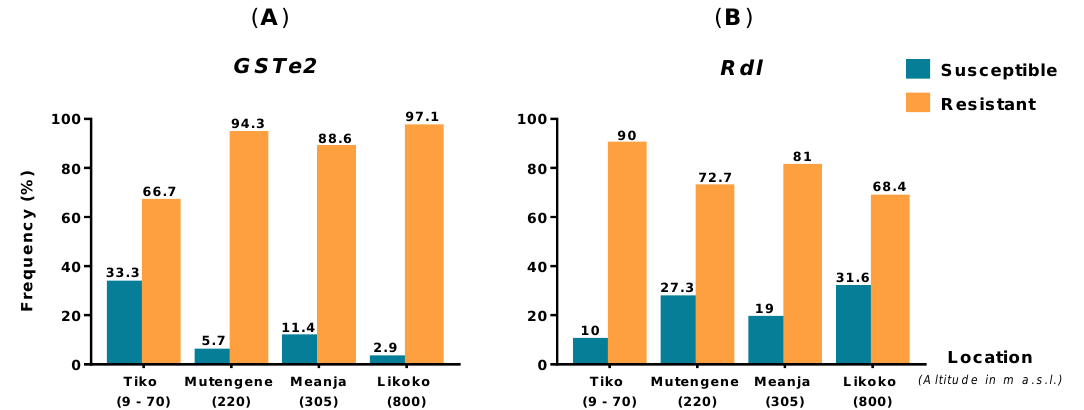
Figure 2. Frequency distribution of GSTe2 ( A ) and Rdl ( B ) mutations in An. funestus s.s. populations from the localities surveyed.